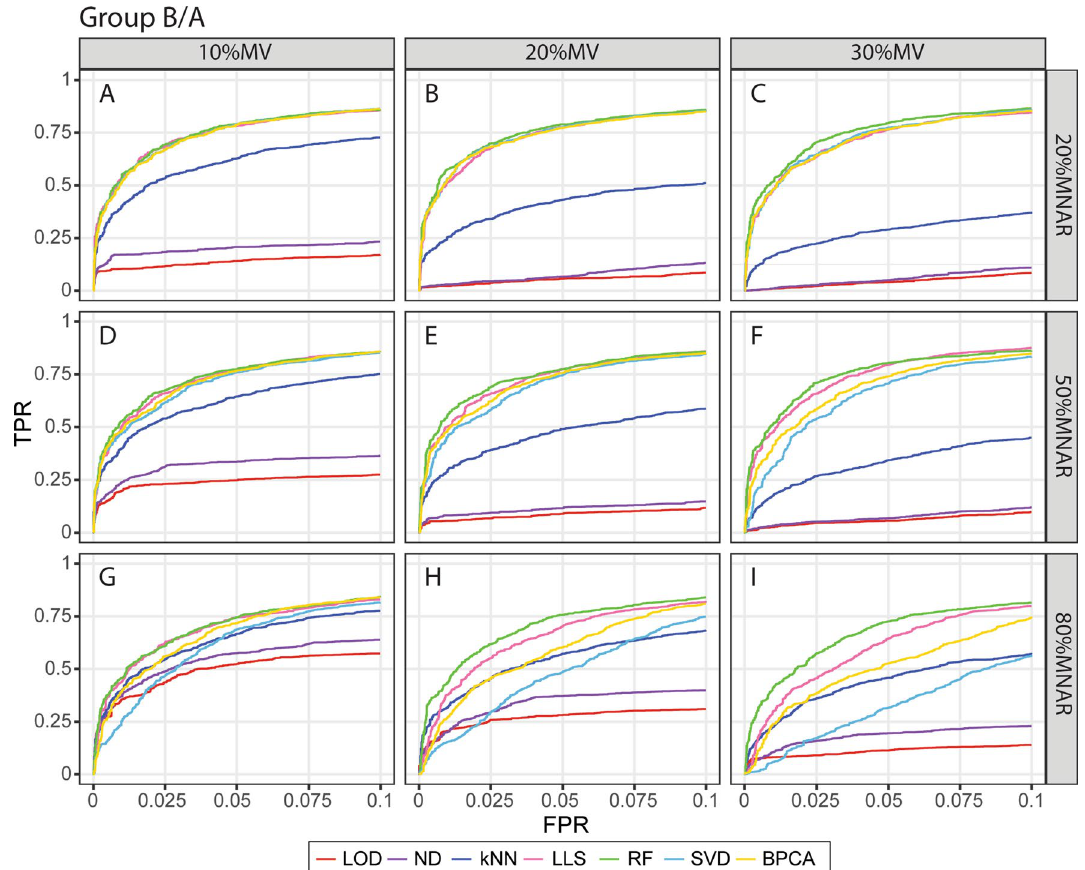
Figure 4. ROC curves of Group B/A with the benchmark dataset. ROC curves are plotted based on the average true positive rate (TPR) and false-positive rate (FPR) of ten repeats in each MV-MNAR condition. E.coli and yeast proteins are considered true positives and human proteins are considered false positives. ( A – I ): 10%MV-20%MNAR, 20%MV-20%MNAR, 30%MV-20%MNAR, 10%MV-50%MNAR,